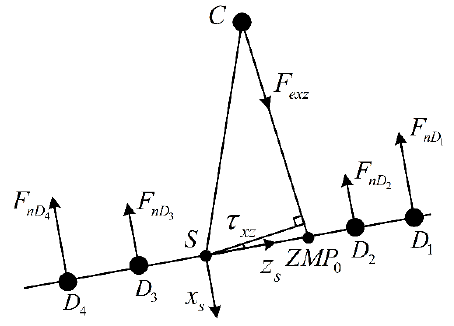
Figure 6. Force diagram in the 𝑥 𝑠 𝑆𝑧 𝑠 plane.